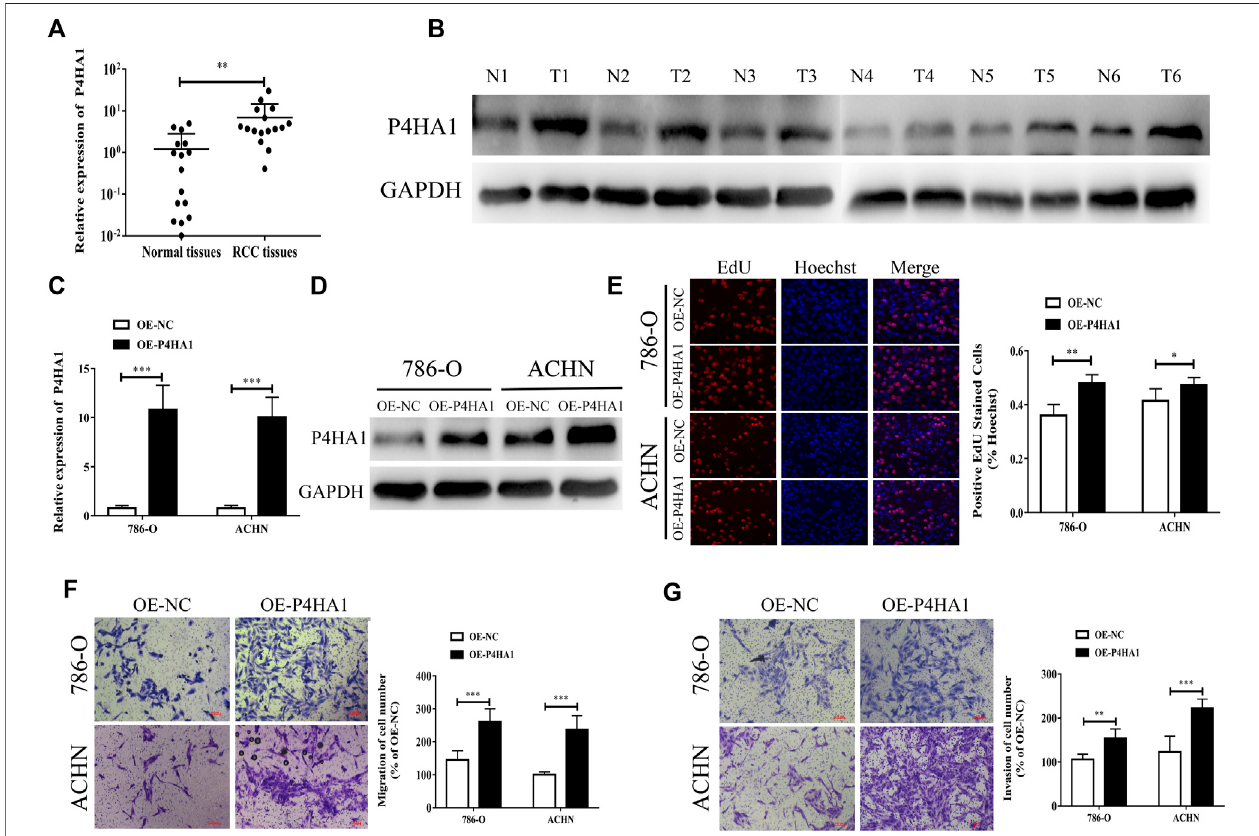
FIGURE7 | P4HA1 could promote the proliferation, migration, and invasionofRCC. (A) QRT-PCR wasconducted todetect themRNA expression level ofP4HA1 in RCC tissues. (B) Western blot assay was conducted to measure the protein level of P4HA1 in RCC tissues. (C) Ef fi ciency of P4HA1 overexpression plasmid (OE- P4HA1)wascon fi rmedbyqRT-PCR. (D) Ef fi ciencyofOE-P4HA1wascon fi rmedbyWesternblot. (E) EdUassaywasconductedtoverifytheeffectofOE-P4HA1oncell proliferation. (F,G) Transwell assay was conducted to verify the effect of OE-P4HA1 on cell migration and